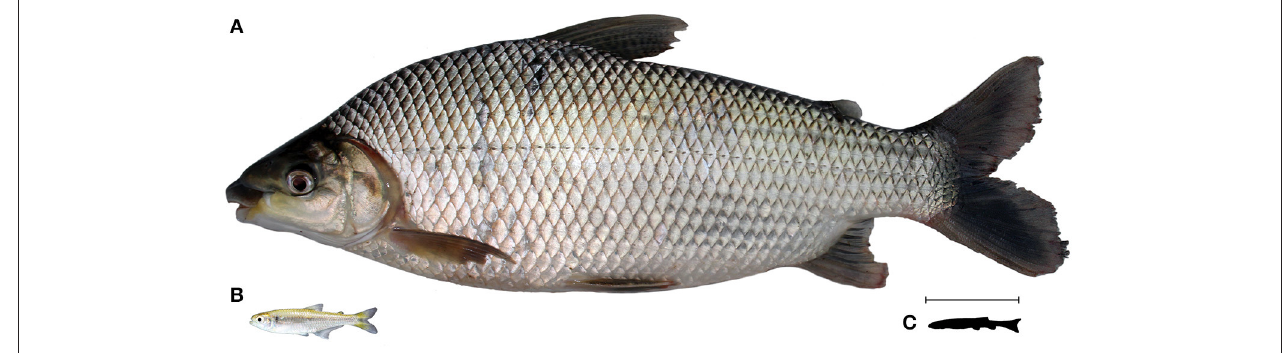
FIGURE 3 | Host species of Pseudostegophilus maculatus represented in scale. (A) Prochilodus lineatus ; (B) Piabarchus stramineus ; (C) Pseudostegophilus maculatus represented in black. Scale bar 50mm.